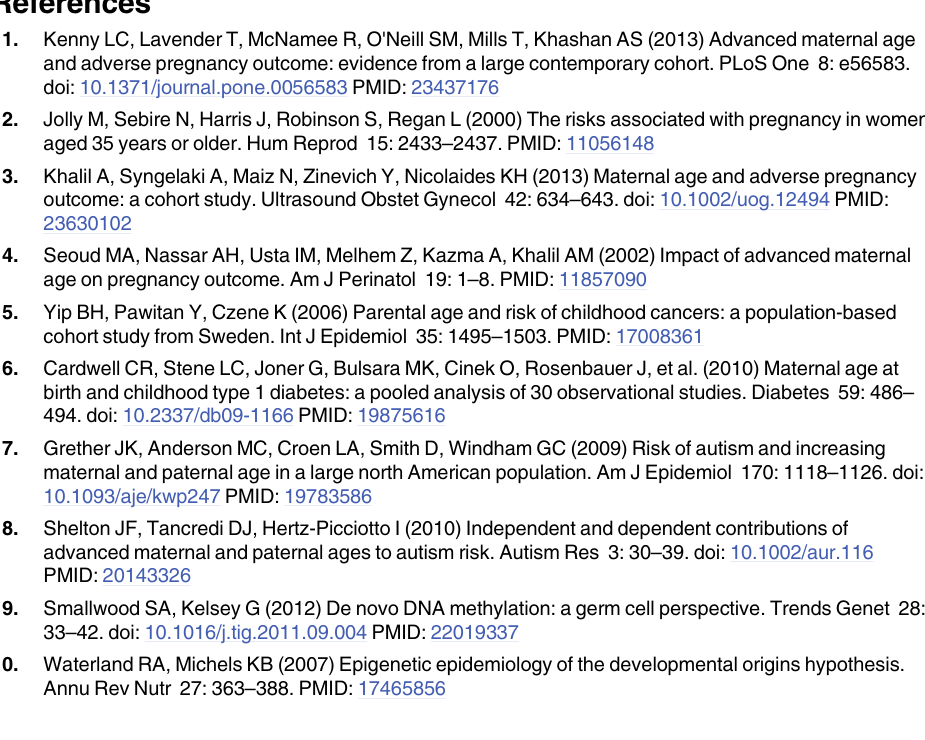
S2 Table. Detailed KLHL35 results across models a in NFCS.